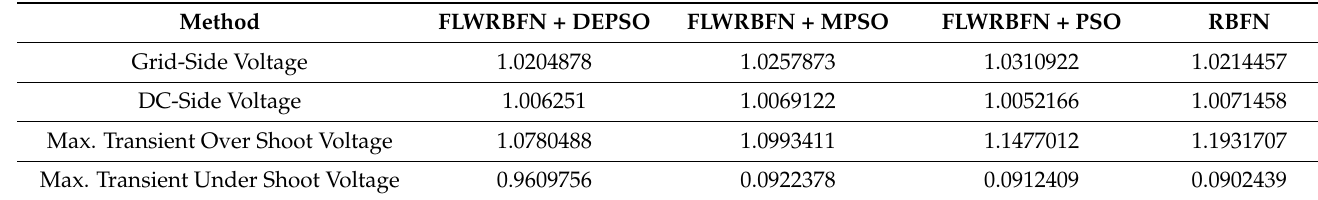
Table 4. System dynamic behavior comparison with short-circuit fault